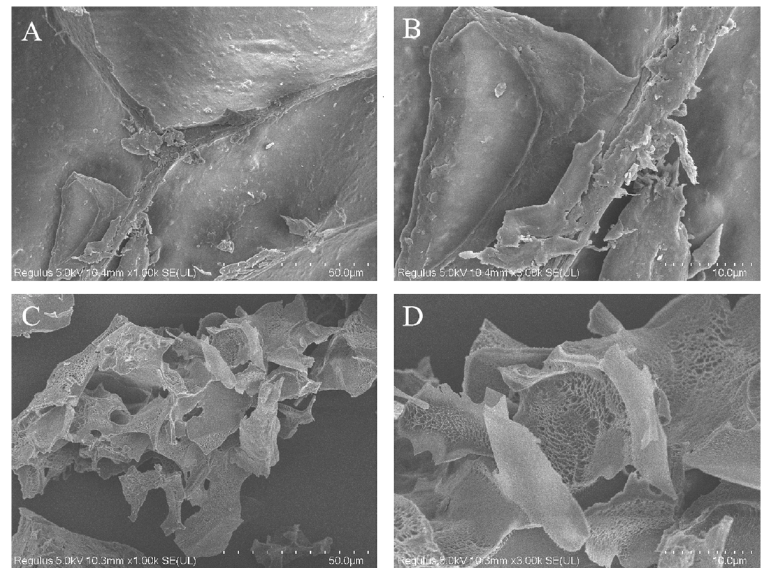
Figure 1. SEM micrographs of untreated soluble dietary fiber (U-SDF) from NOP (( A ): × 1000 magnification; ( B ): × 3000 magnification) and soluble dietary fiber from NOP-IDF by mixed SSF (M-SDF) (( C ): × 1000 magnification; ( D ): × 3000 magnification).